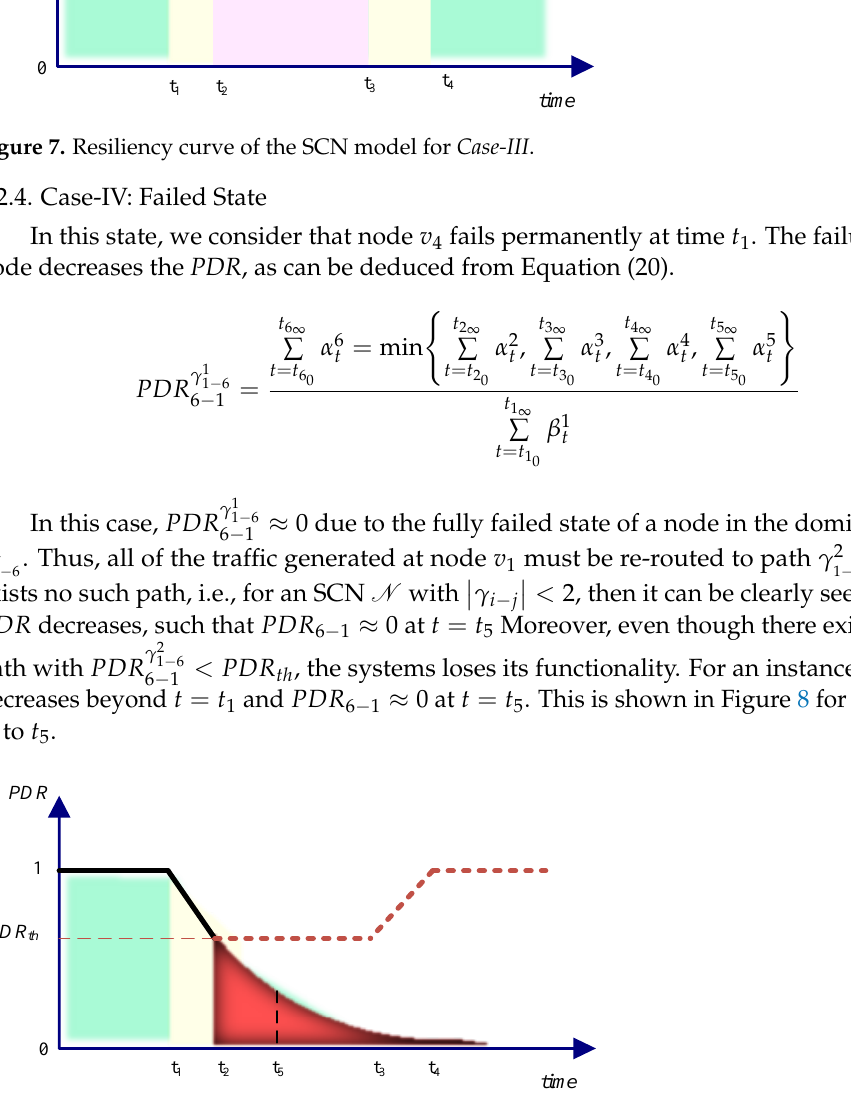
Figure 8. Resiliency curve of the SCN model for Case-IV .